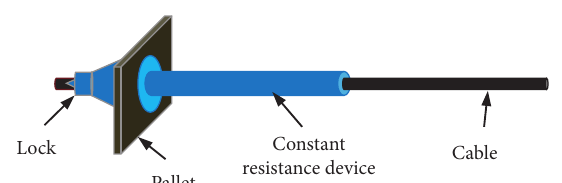
Figure 7: Structure of constant resistance large deformation an- chor